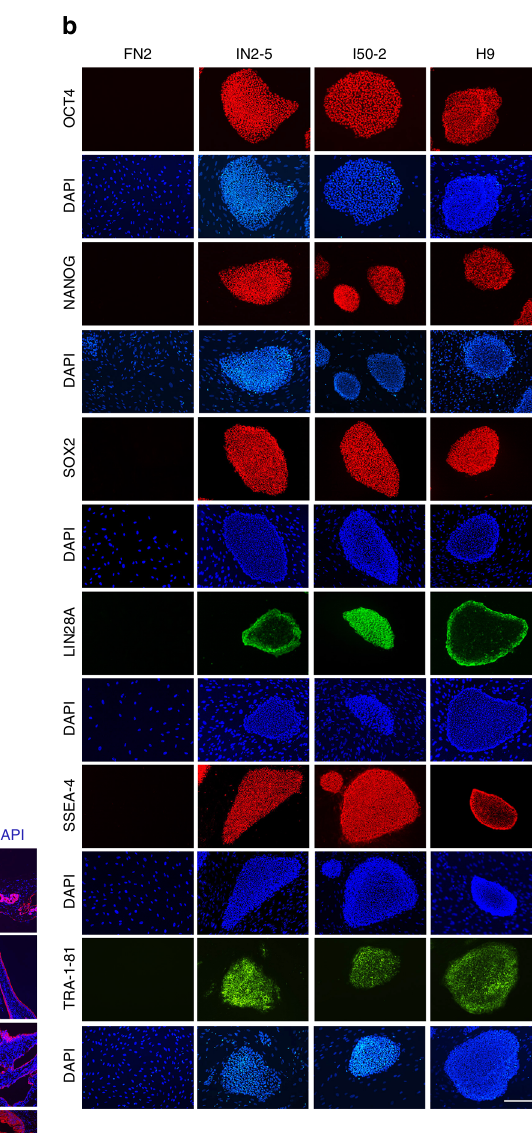
inactivated fetal bovine serum (HI-FBS), 1× MEM non-essential amino acids solution, 55µM of 2-mercaptoethanol ( β -ME), 1× GlutaMAX TM supplement, plus antibiotics (all from Thermo Fisher Scienti fi c), until the cells reached 46 population doublings (PDs). Senescence was con fi rmed by β -galactosidase activity using a Senescence β -Galactosidase Staining Kit (Cell Signaling Technology) according to the manufacturer ’ s instruction. Pluripotent stem cells were cultured in a 5% O 2 /5% CO 2 tissue culture incubator and maintained either in N2B27 medium comprising a mixture of